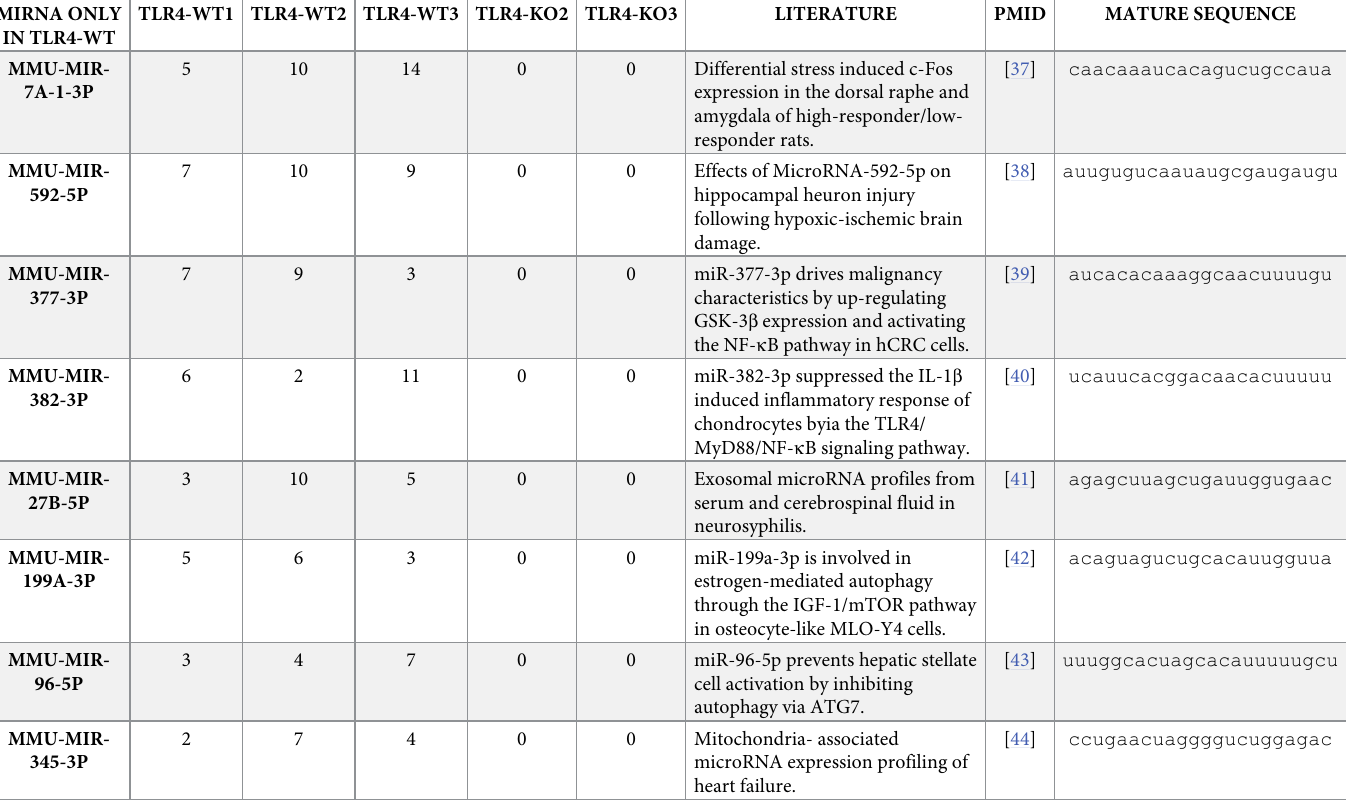
Table 3. Exclusive miRNAs in the TLR4-WT mice. The table shows the total counts and a selected article about their function.